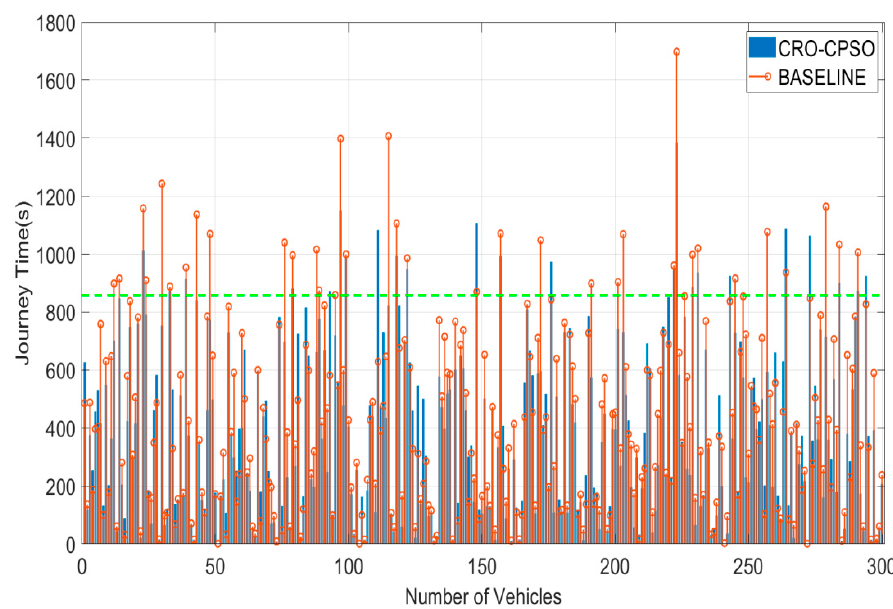
Figure 8. Comparison performance diagram of the driving time of 300 vehicles after CRO-CPSO strategy optimization (the green-dotted line is T (cid:2952) ).